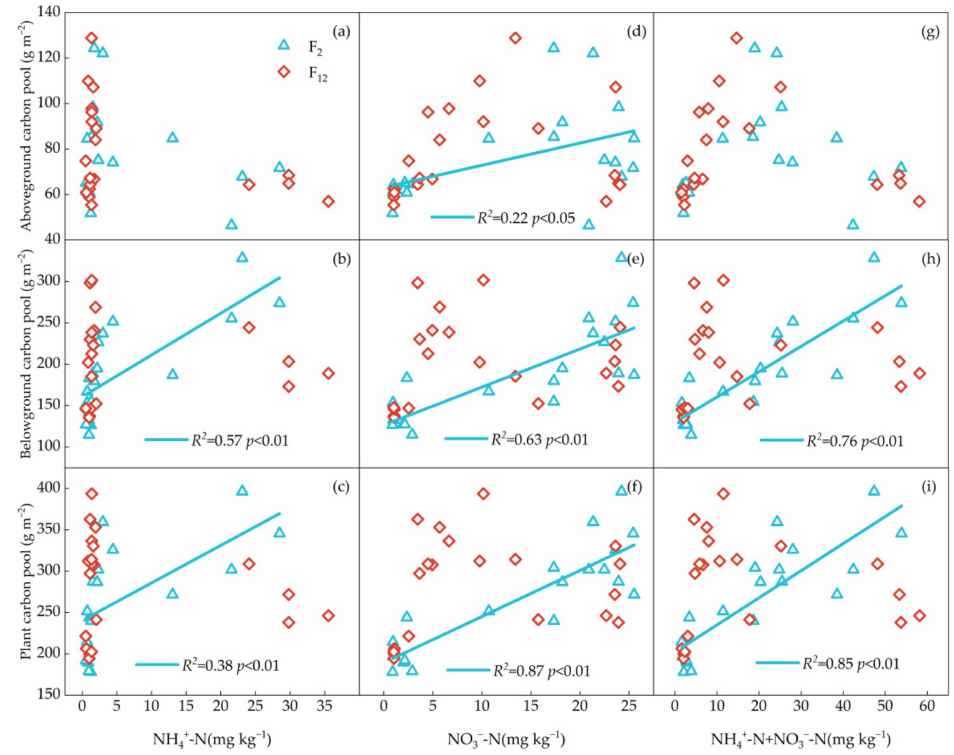
Figure 4. The relationships between PAGC, PBGC, PC and soil NH 4+ -N concentration ( a – c ), soil NO 3 − -N concentration ( d – f ) and soil NH 4 + -N +NO 3 − -N concentration ( g – i ). Blue triangles with solid lines indicate 2 N additions yr − 1 (F 2 ). The red quadrilateral and dotted line indicate once a month (F 12